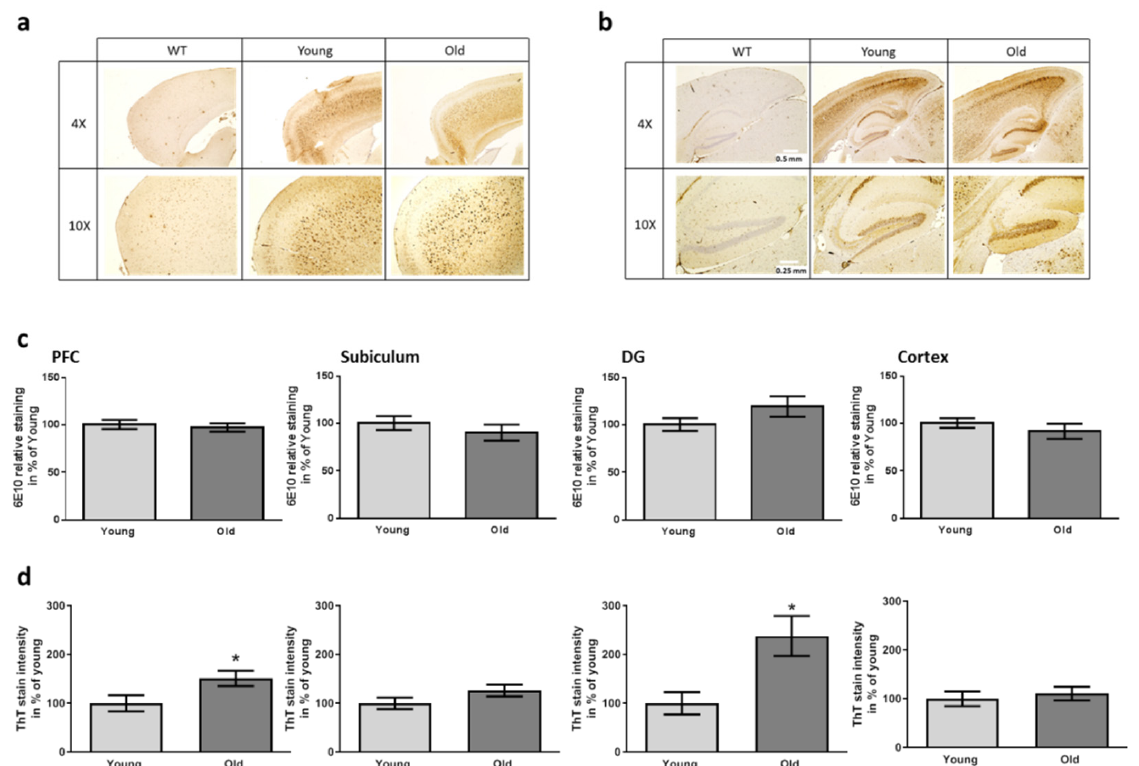
Figure 5. A β and plaque staining in brain regions of 5xFAD mice after having received FMT. The area of the prefrontal cortex (( a ), PFC) and the hippocampal area (( b ), DG: dentate gyrus) were stained with antibody 6E10. Scale bars represent 0.5 and 0.25 mm (4 × and 10 × magnification). Exemplary pictures in comparison to a wild type sample are shown. ( c ) Quantitative analysis of the staining intensity using defined area-sizes (as described previously [32]). ( d ) Quantitation of ThT-dependent plaque staining. For exemplary pictures of this staining please see Supplementary Figure S4. Two slides per mouse were analyzed. Data are presented as mean ± SEM in % of the mean of animals treated with caecum content from young donors (( c , d ): n = 9 for transgenic mice treated with cecal material from young and 10 for mice treated with old donor material (designated “young” and “old”) (*, p < 0.05)).